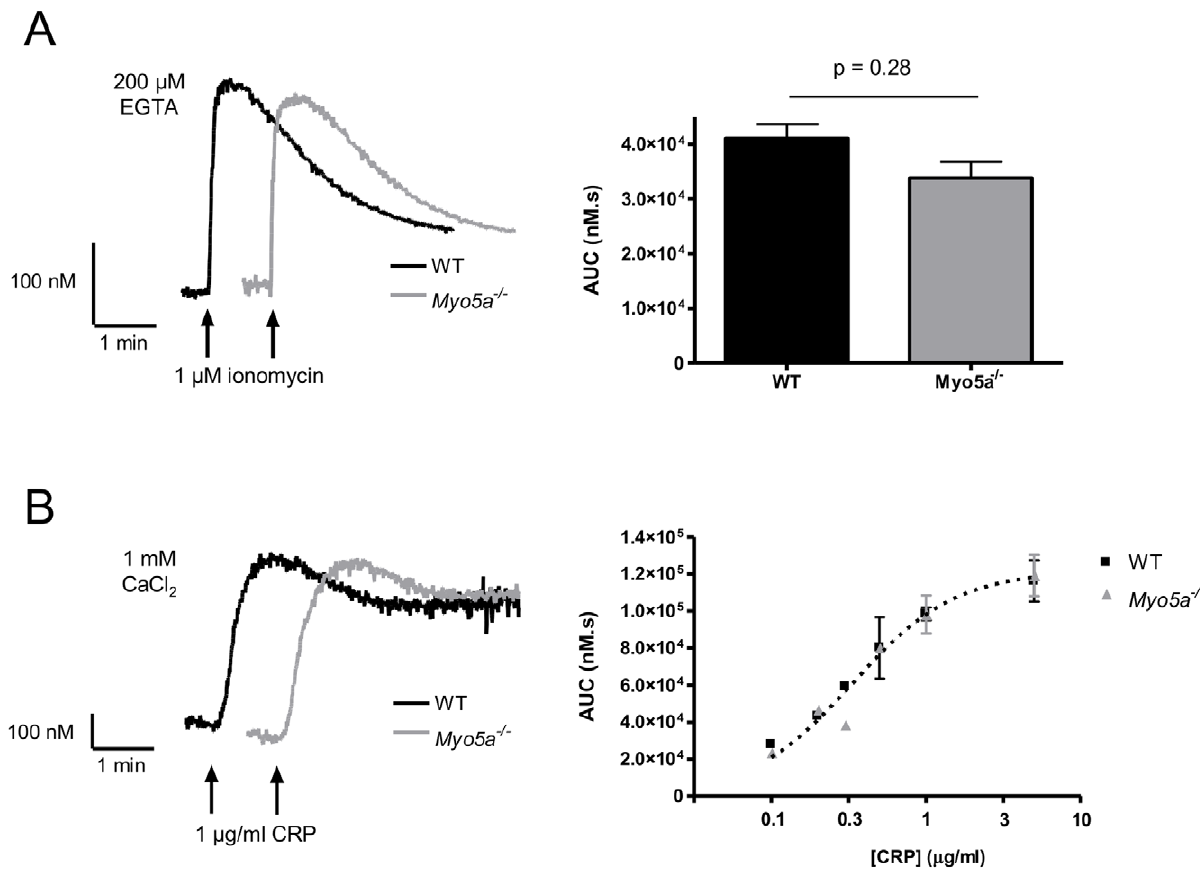
Figure 6. Normal Ca 2 + signalling in Myo5a 2 / 2 platelets. Wild-type and Myo5a 2 / 2 platelets were loaded with the Ca 2 + -sensitive dye Fura-PE3. (A) Ionomycin (1 m M) was added in presence of the calcium chelator EGTA (200 m M). (B) Platelets were stimulated with the indicated concentrations of CRP in the presence of 1 mM CaCl 2 . The left hand panels show representative traces (n=3). Data in the right hand panels (mean + / 2 SEM, n=3) are expressed as area under the curve (AUC).